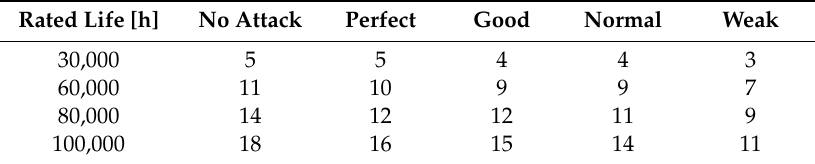
Table 6. Remaining lives of bearings in di ff erent system